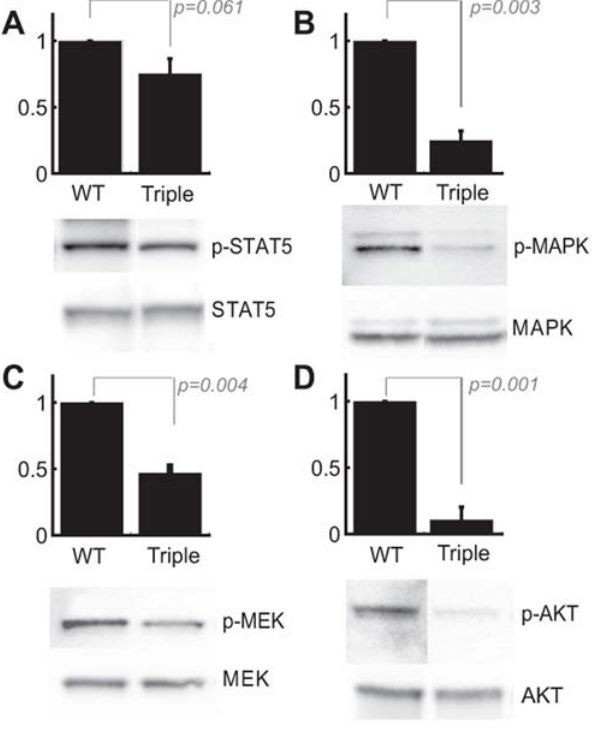
Figure 5. Activation state of various signaling pathways, in the triple mutant BCR-ABL expressing cells, relative to wild type. 32D cell lines expressing either wild type or triple mutant BCR-ABL were lysed and the activation state of the indicated signaling pathways was detected by immunoblotting whole cell lysates with phosphospecific antibodies for each pathway. (A) phospho-STAT5; (B) phospho-MAPK; (C) phospho-MEK; (D) phospho-AKT. The levels of phosphorylation were normalized for the whole cell levels of the protein shown in the lower panel of each immunoblot. (A) STAT5; (B) MAPK; (C) MEK; (D) AKT. Phosphorylation levels are reported relative to wild type (upper panels). Data represents three independent experiments with a representative blot